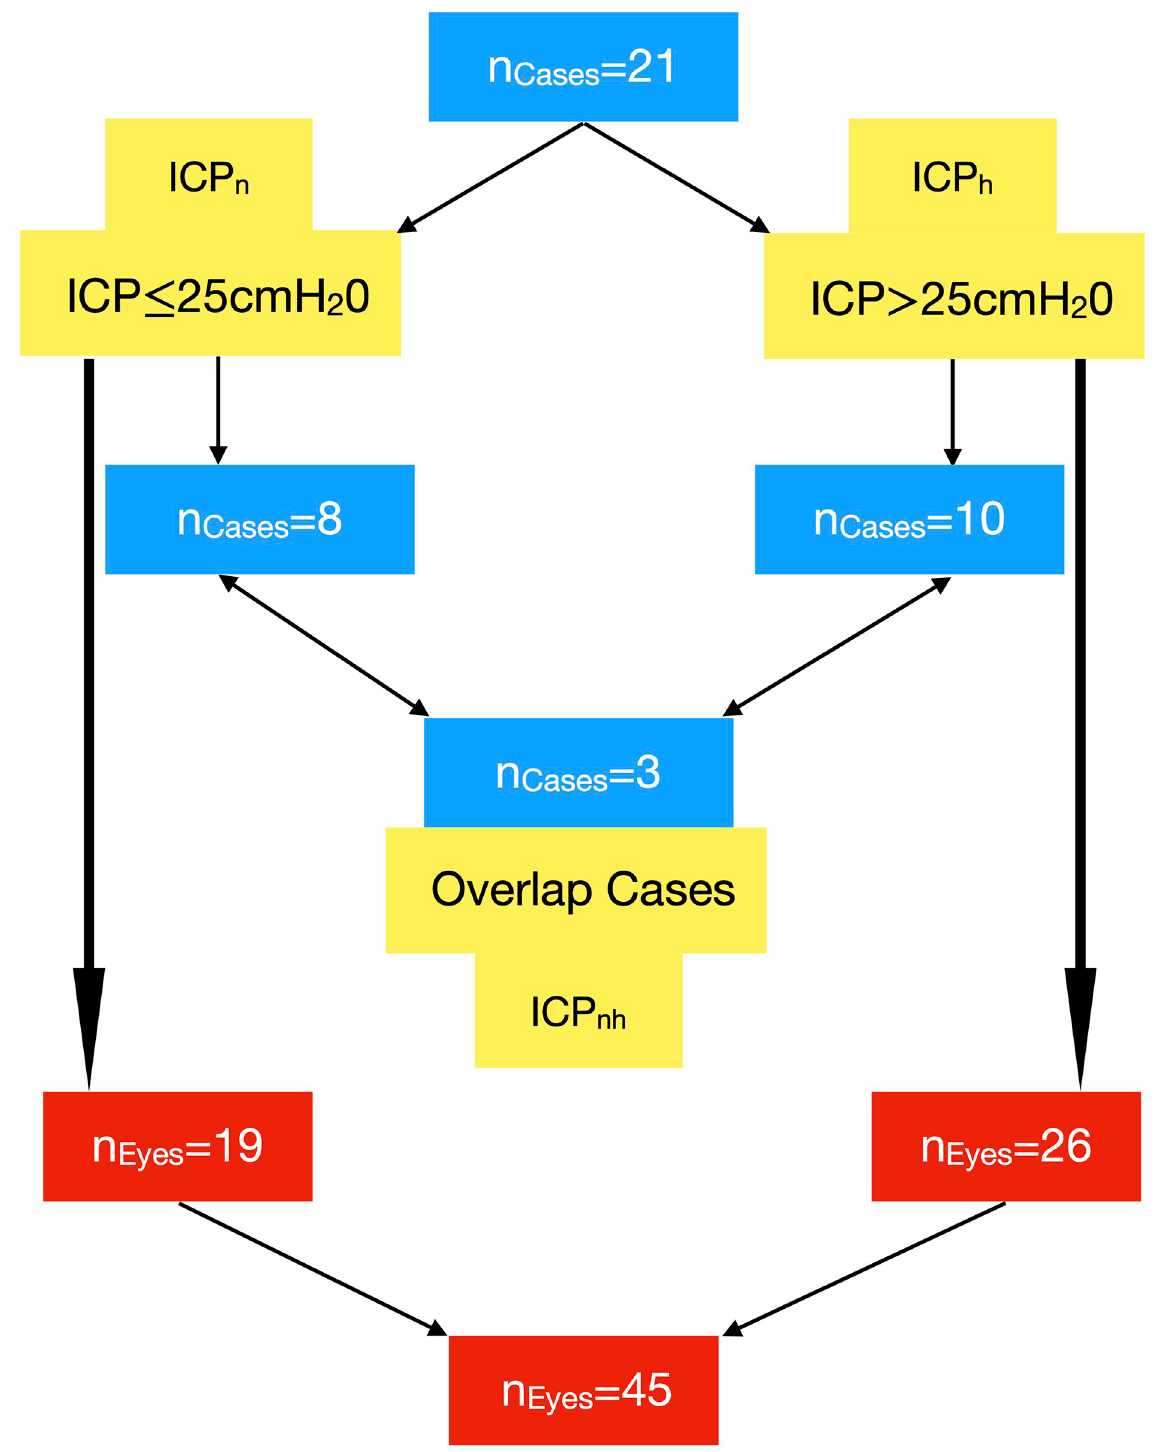
Fig 1. Classification of the study population. Training and test groups study groups, patients with normal intracranial pressure ICP n (ICP � 25cm water) and high intracranial pressure ICP h (ICP > 25cm water).